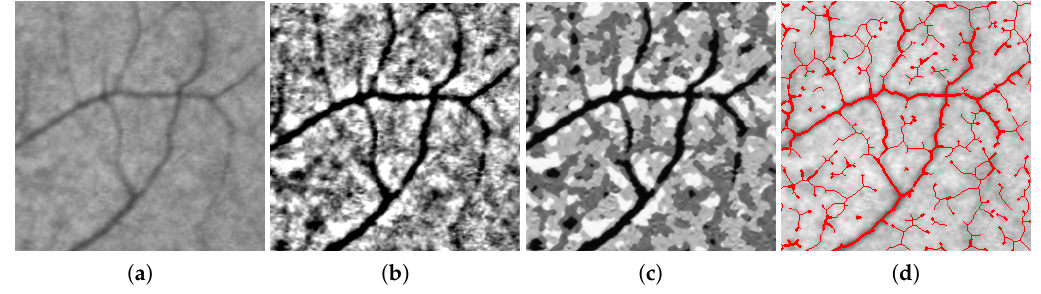
Figure 11. ( a ) Original image, ( b ) image after background removal ( c ) segmented output, ( d ) segmented output with